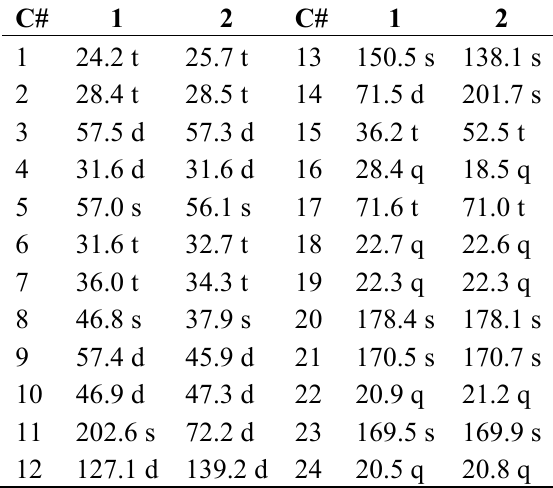
Table 2. 13 C-NMR data (100.25 MHz) for the new compounds 1 and 2